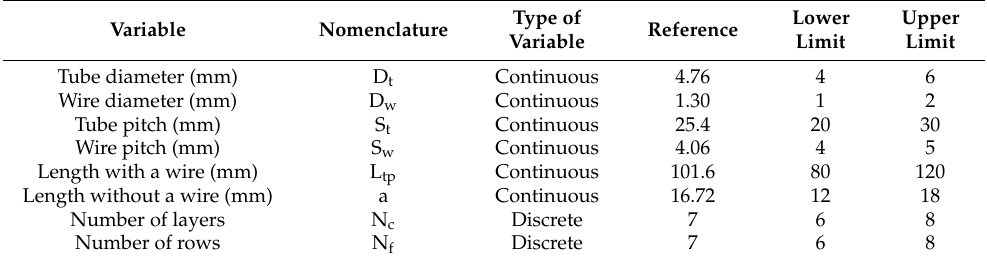
Figure 1. Schematic representation of the multilayer wire-on-tube condenser. Table 1. Geometric parameters of the multilayer wire-on-tube condenser. Table 1. Geometric parameters of the multilayer wire-on-tube condenser.